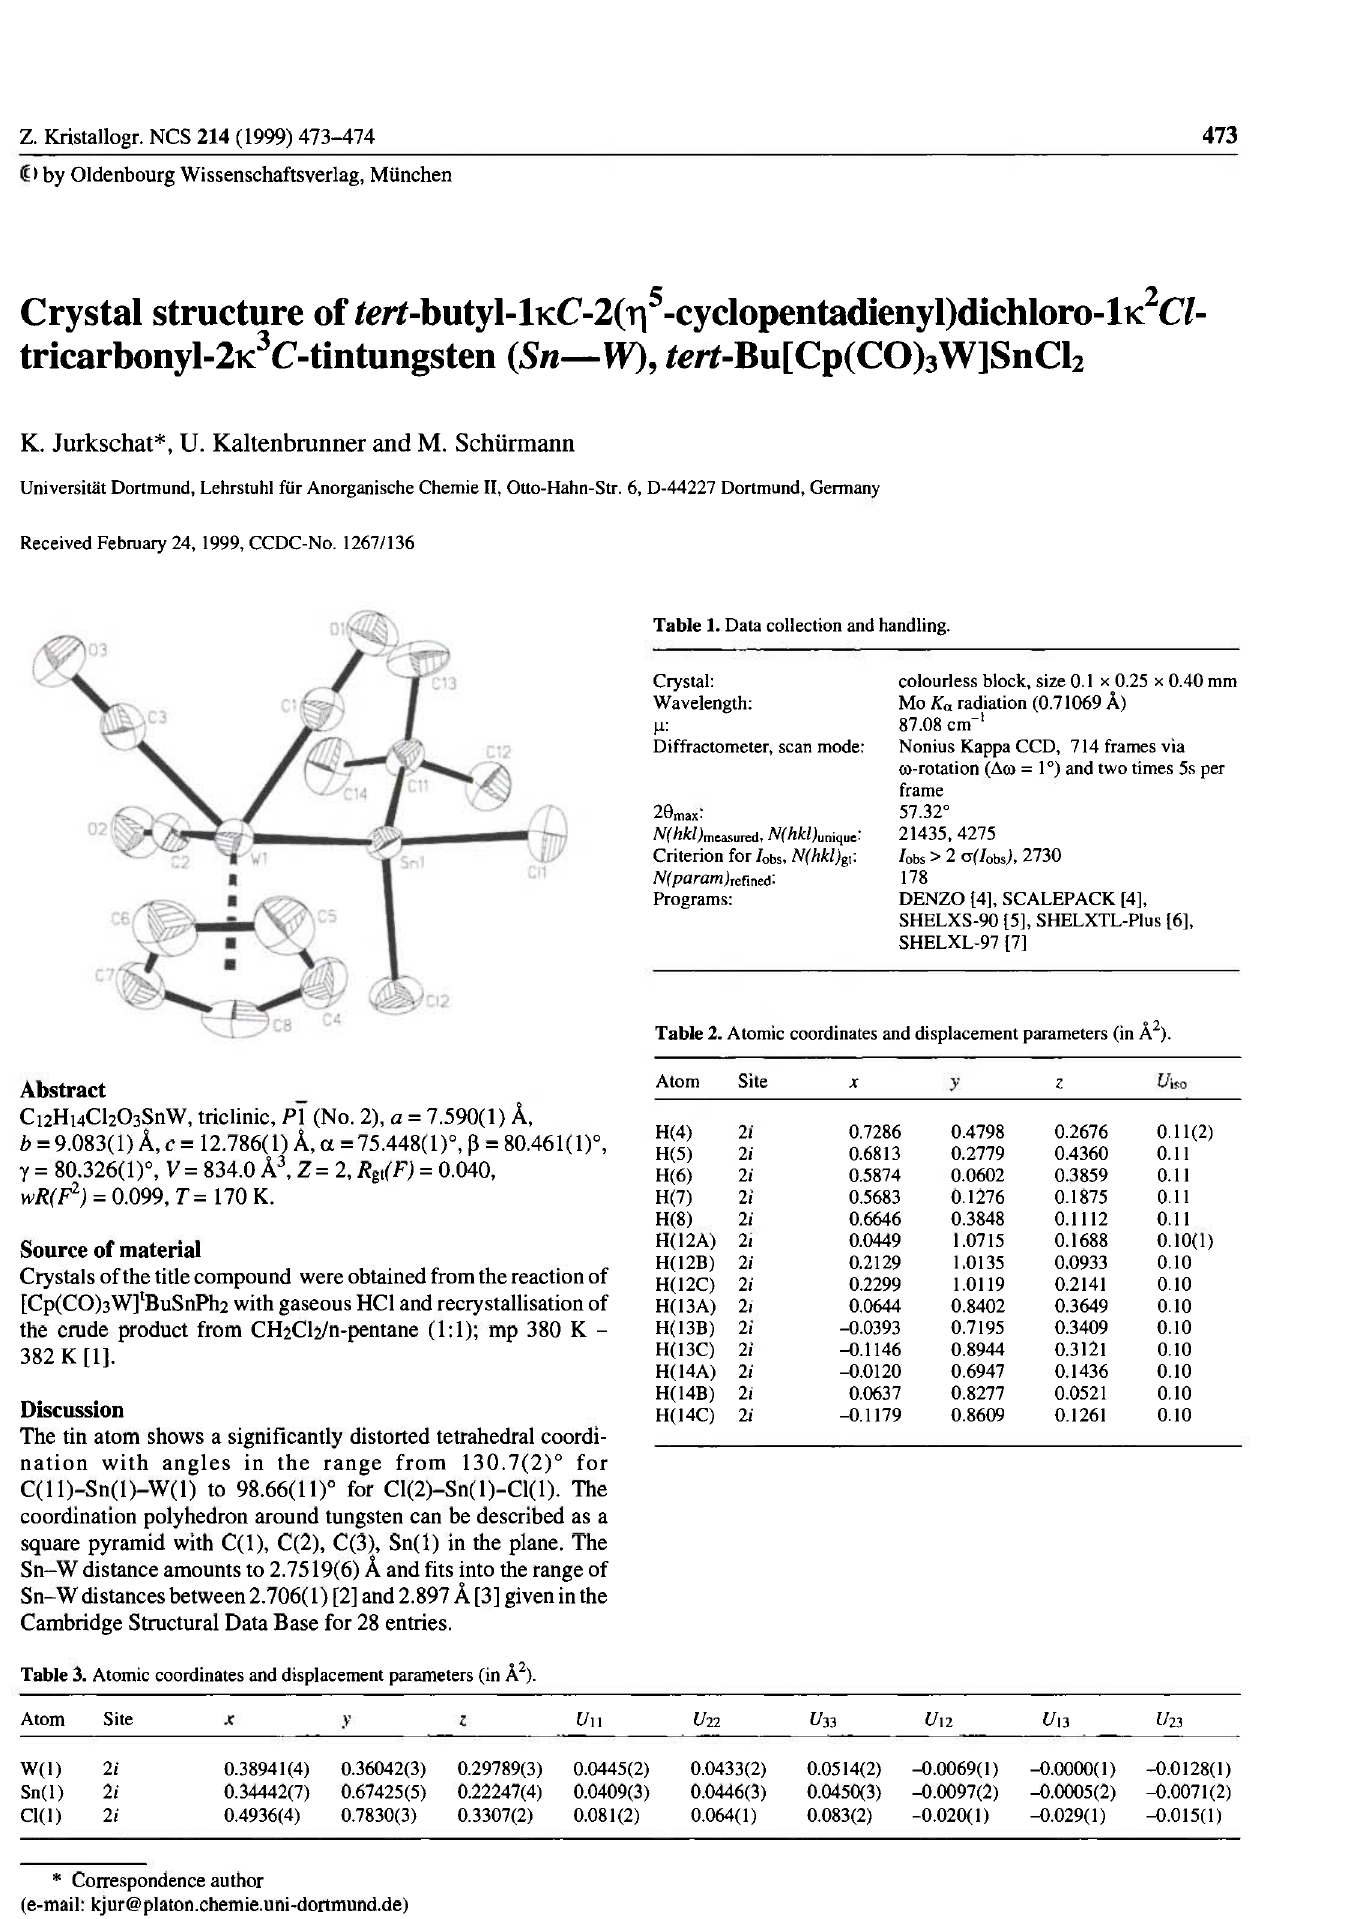
Table 3. Atomic coordinates and displacement parameters (in Ä 2 ).